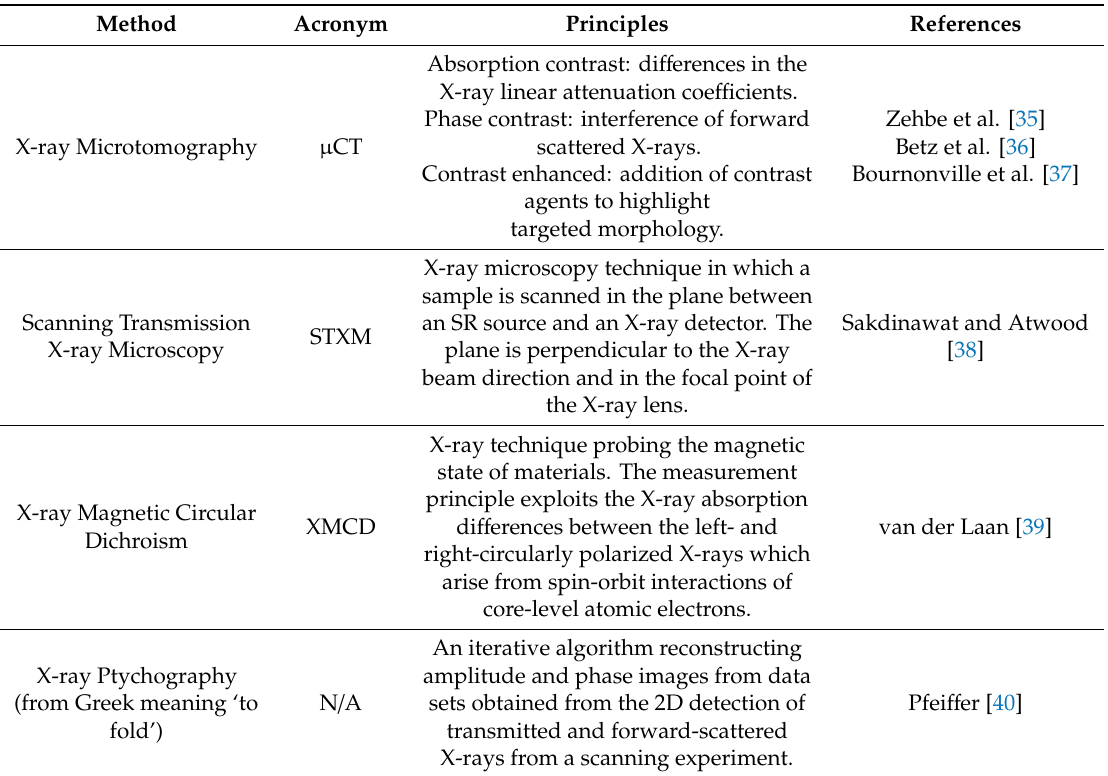
Table 1. List of X-ray synchrotron-based methods used in trace elemental analysis of biological